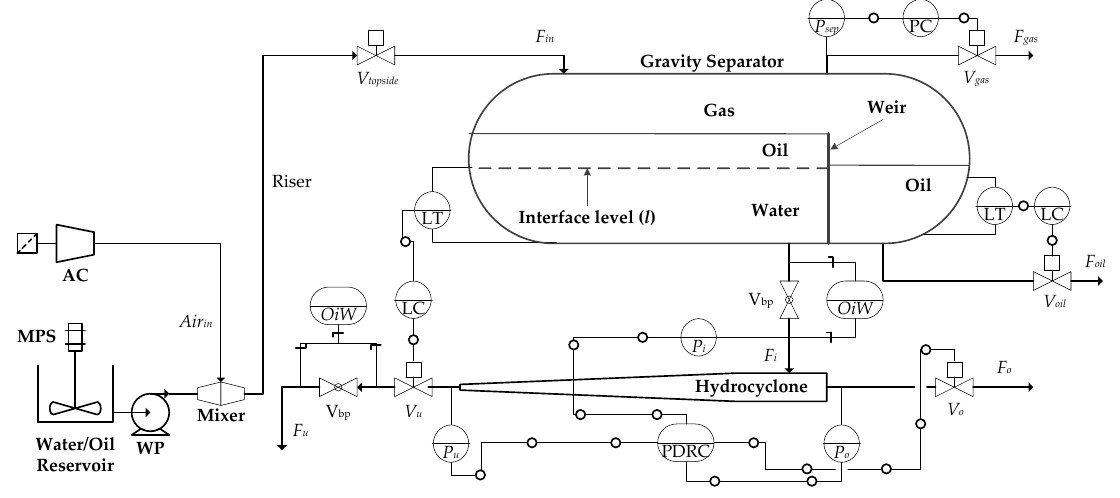
Figure 1. Simplified P&ID of the pilot